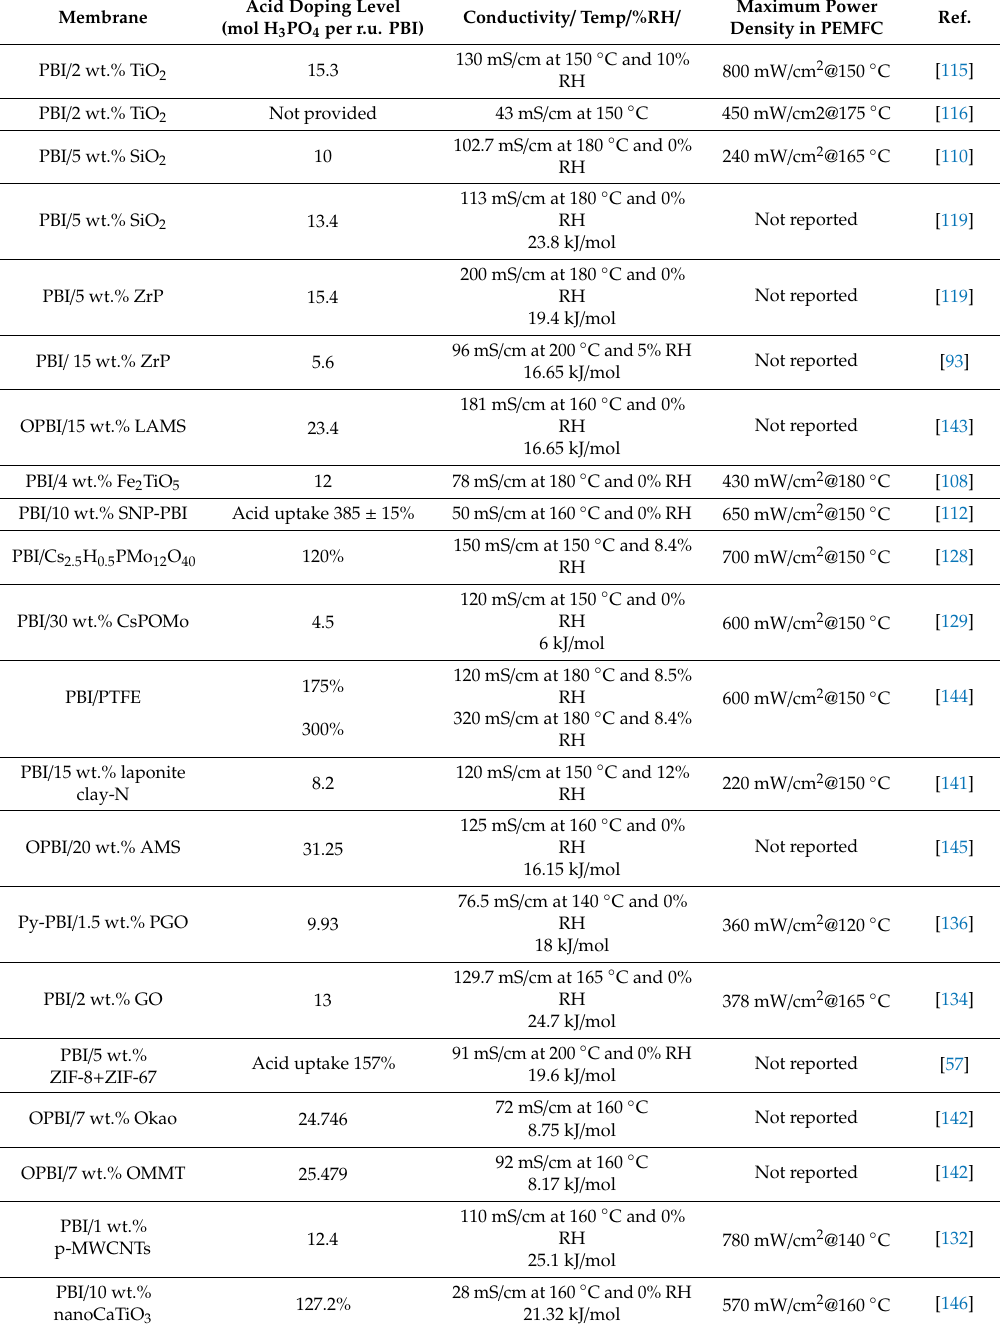
Table 3. Comparison of proton conductivities of H 3 PO 4 –PBI-based composite membranes and their PEMFC